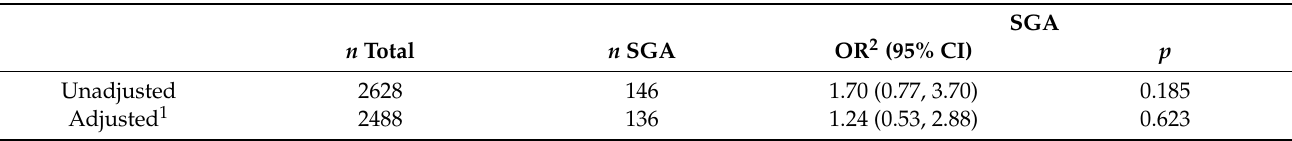
Table 7. Associations between maternal selenium concentration in whole blood and small for gestational age status in 2628 women from the Norwegian Mother, Father and Child Cohort